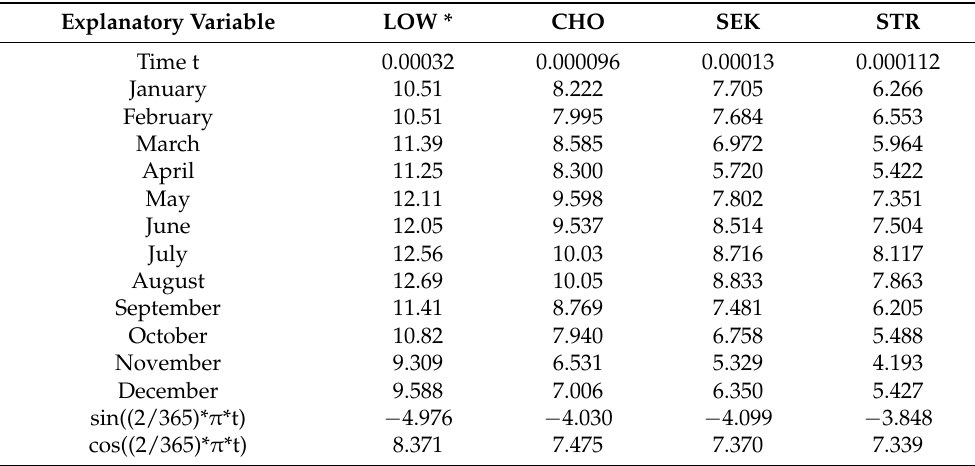
Table 2. Time series regression for the temperatures in the four summits. Explanatory Variable